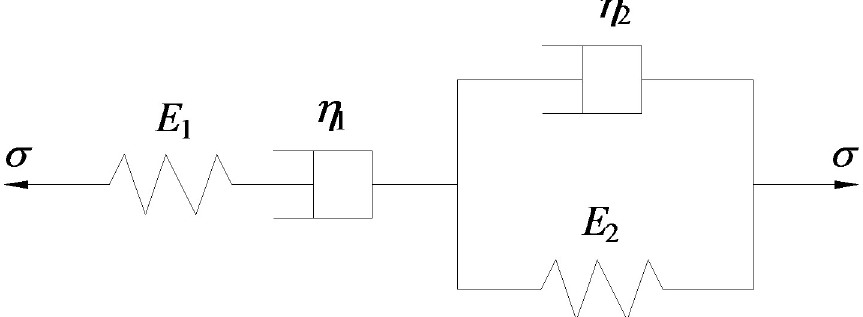
Fig 4. Schematic diagram of Burgers creep